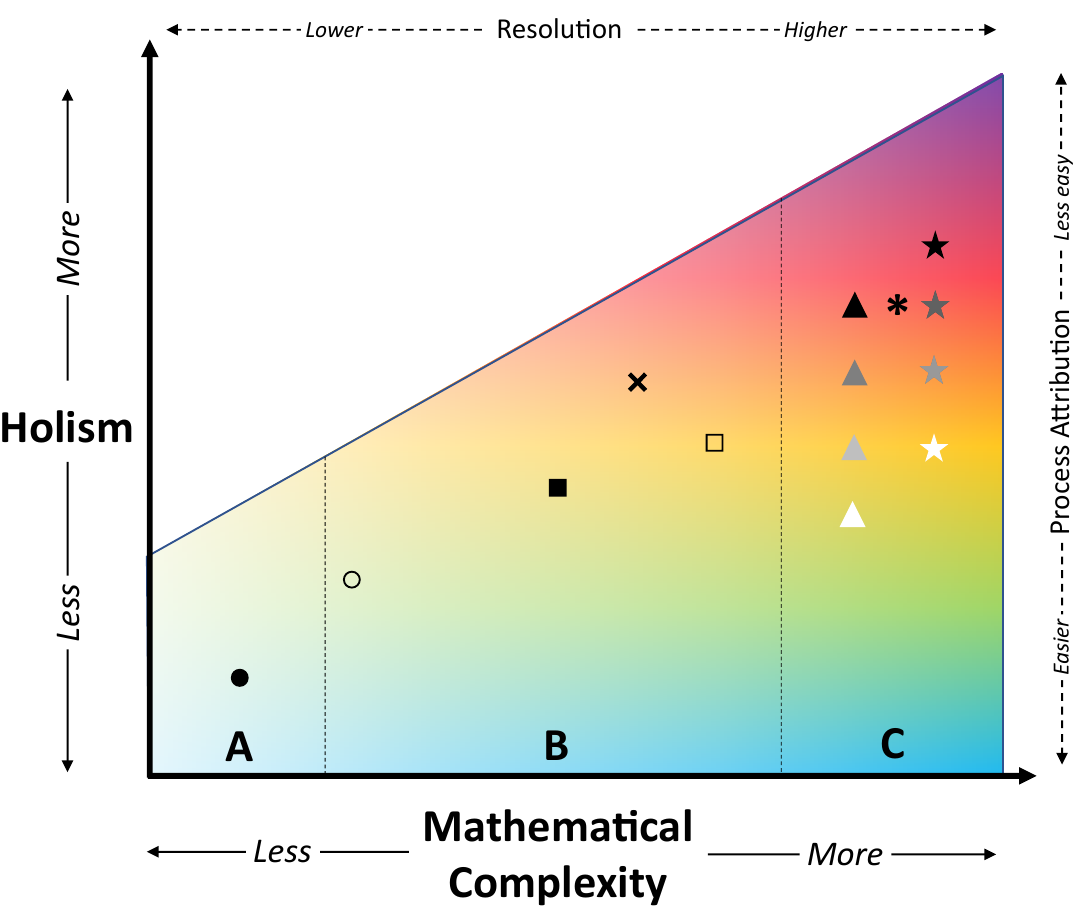
Figure 26. Schematic of diagnostic timescale holism as a function of the mathematical complexity of the calculation method (for computed timescales only). Timescales based on simple algebraic expressions tend to be less holistic, but potentially more useful for purposes of assessing dominant processes (Regime A). Complex numerical models have the potential to produce highly holistic timescales (Regime C) as well as timescale estimates at high spatial and temporal resolution. The e ff ective level of holism depends on the process richness captured by the model simulation. More holistic timescales may be less useful for disentangling the relative speeds (and potential dominance) of individual processes (“process attribution”). Moderately holistic timescales may be derived from moderately complex numerical models or methods (Regime B) or from complex models that exclude some important processes (mid-region of Regime C). Examples: • — τ adv = L / U or τ di ff = L 2 / K. and τ exp from Andutta et al. [22], Equations (9) and (10) herein. Timescales derived from the 1D models of Delhez and Deleersnijder [200] or Vallino and Hopkinson [160] (); the 2D depth-averaged model of Monsen et al. [87] ( (cid:3) ); the 1D hydrodynamic-biological model of Delhez et al. [189] ( × ); the 3D hydrodynamic and transport model of Gross et al. [174] ( ∗ ); the 3D hydrodynamic and particle tracking model described by Defne and Ganju [101], with progressively more physical processes included (starting with white triangle progressing upward to black triangle; also see Figure 10 herein); the 3D hydrodynamic-ecological model of Ralston et al. [127] with progressively more physical processes and dinoflagellate swimming behaviors (starting with white five-pointed star up to black five-pointed star; also see Figure 25